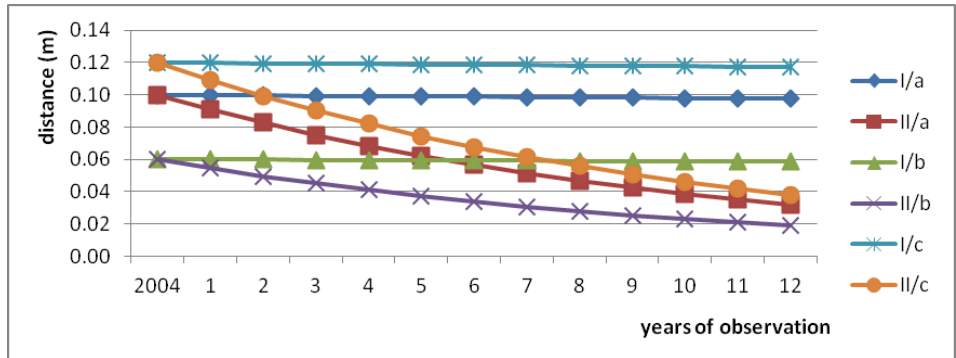
Figure 7. Variability in the spacing between branches in both directions of flow in years.